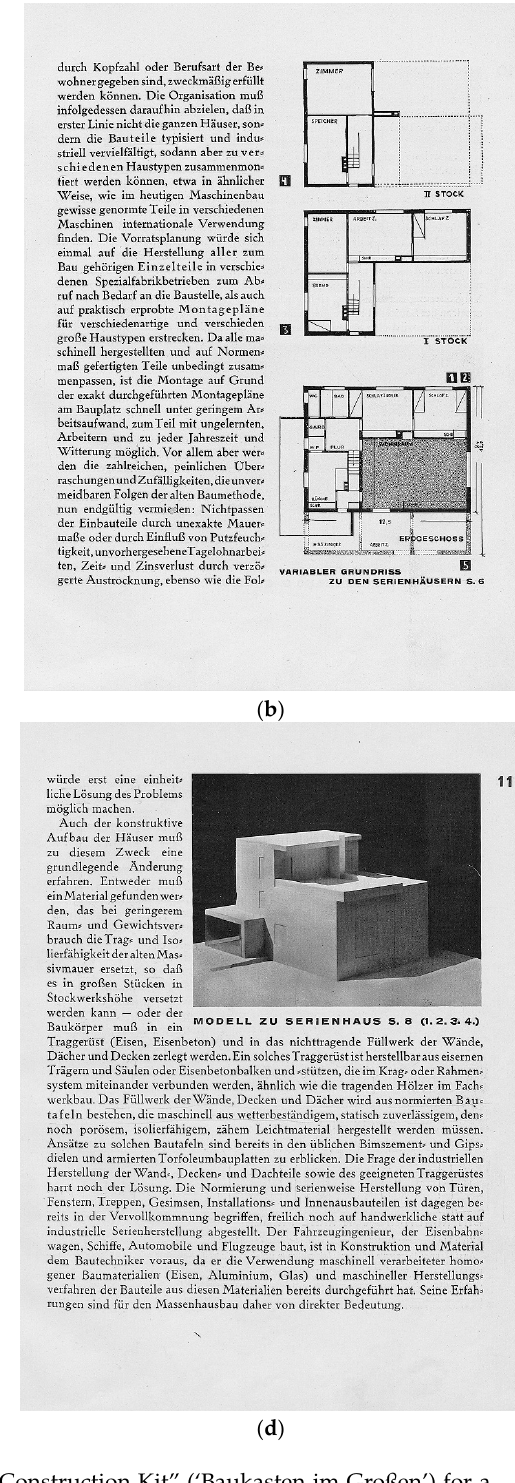
Figure 7. Walter Gropius and Adolf Meyer: “Big Construction Kit” (‘Baukasten im Großen’) for a “Serial House Type” (‘Typenserienhaus’), 1923—Conceptual diagrams, floor plans and model photos. Images from (Meyer 1925a, pp. 8–11).